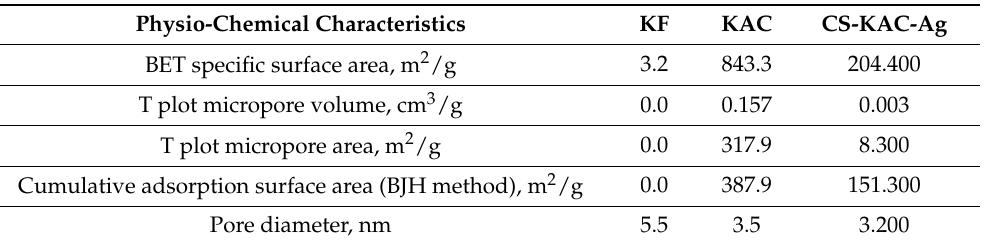
Table 3. Physio ‐ chemical characteristics of KF, KAC, and CS ‐ KAC ‐ Ag for the adsorption of Cd 2+ . Table 3. Physio-chemical characteristics of KF, KAC, and CS-KAC-Ag for the adsorption of Cd 2+